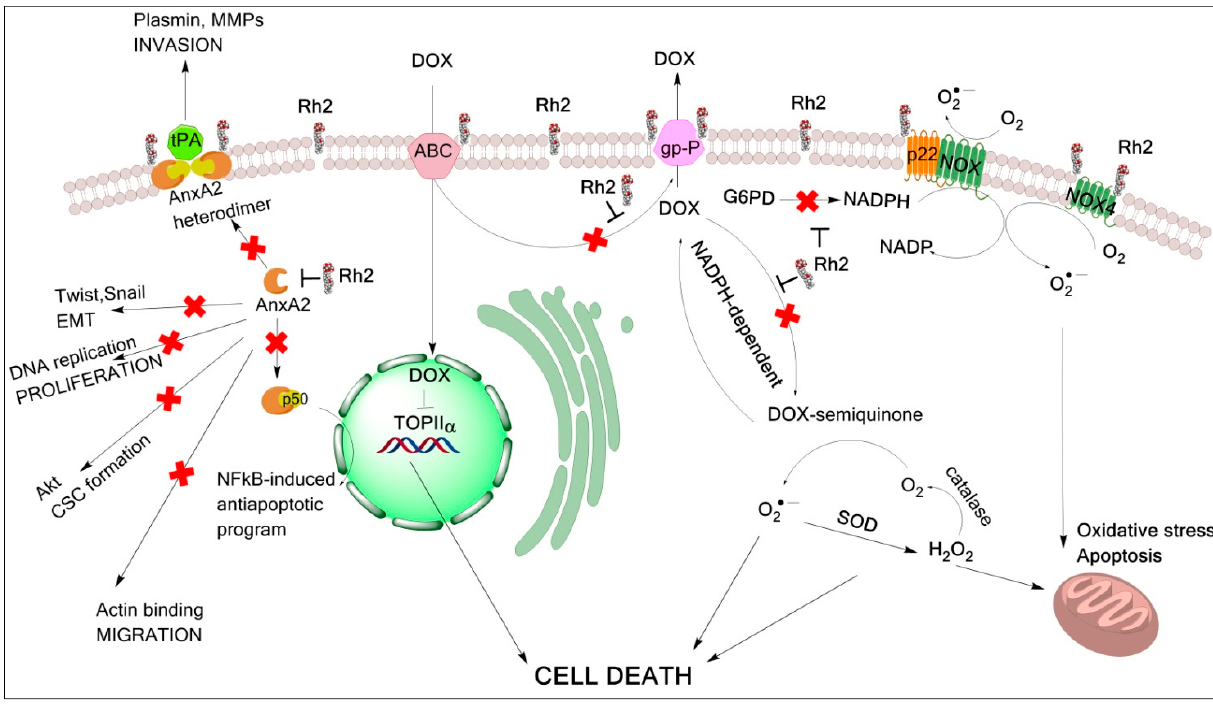
Figure 10. Molecular mechanisms underlying benefits of Rh2-DOX co-treatment in cancer. Major pathway for DOX anti-tumor effect is presented by DOX inhibition of topoisomerase IIa (TOP IIa) shown in the center. Internalization of lipid rafts with Rh2 increases membrane permeability for DOX, which enters the cell through ABC-type transporters. Rh2 inhibits P-glycoprotein (gp-P) which lowers DOX intracellular concentration and is responsible for development of drug resistance. DOX side effects may originate from ROS-production which is NADPH-dependent, and Rh2 inhibits NADPH-dependent DOX redox cycling and possibly glucose-6-phosphate dehydrogenase (G6PD), by analogy with structurally similar enzyme inhibitors. Antimetastatic and anti-apoptotic pathways (left) are inhibited due to Rh2 interaction with annexin A2 (AnxA2). Abbreviations: SOD—superoxide dismutase; NOX—NADPH oxidase; p22—coactivator of NOX; p50—sub-